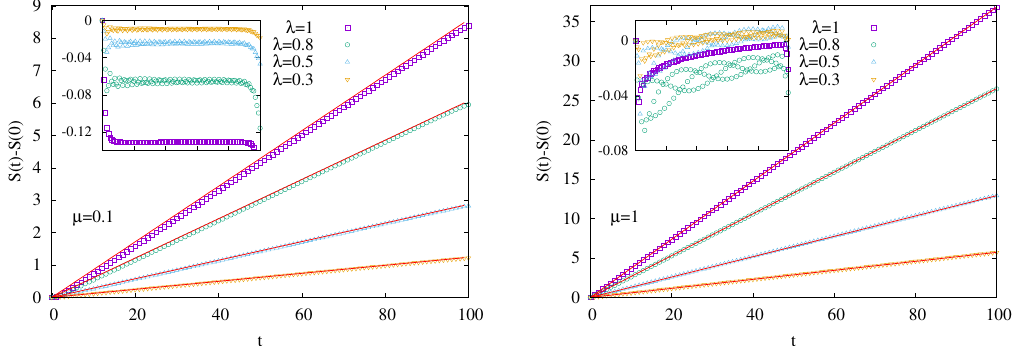
Figure 6: Entropy growth after a global quench with mass parameters µ = 0.1 (left) and µ = 1 (right), for various defect strengths λ and L = 100. The red lines show the quasiparticle ansatz with slope (57), while the insets show the corresponding deviations.